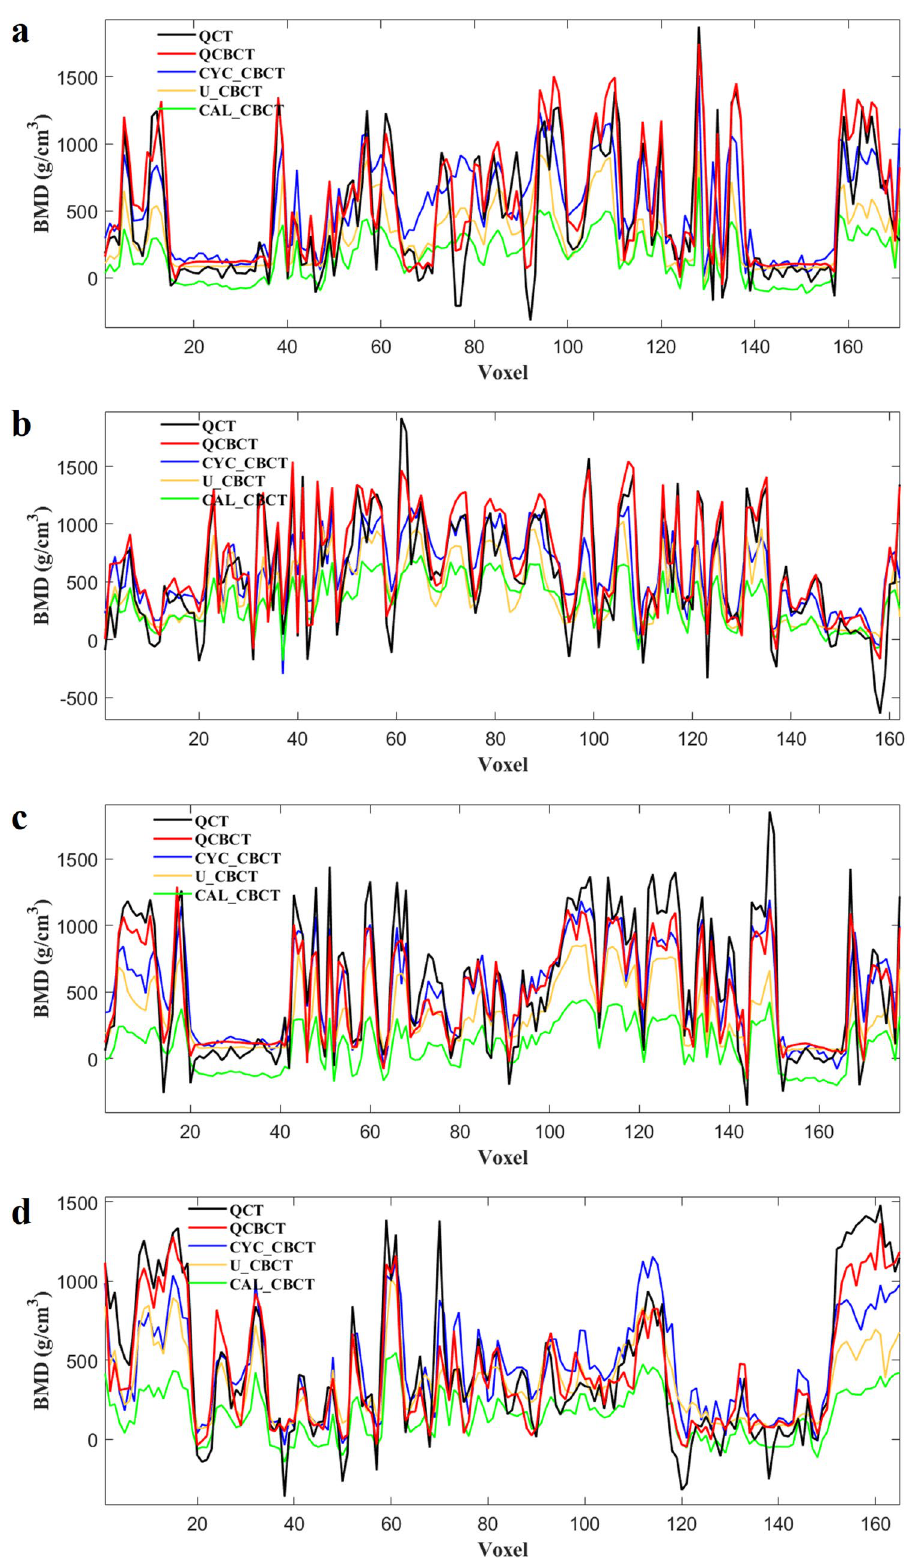
Figure 4. The BMD (voxel intensity) profiles along the dental arch at the maxilla and the mandible in the QCT, and QCBCT, CYC_CBCT, U_CBCT, and CAL_CBCT images shown in Fig. 2. Pearson correlation coefficients of QCBCT, CYC_CBCT, U_CBCT, and CAL_CBCT with the original QCT were ( a ) 0.92, 0.65, 0.60, and 0.65, respectively, for the profile at the maxilla and, ( b ) 0.93, 0.70, 0.65, and 0.69, respectively, for the profile at the mandible shown in Fig. 2b, and ( c ) 0.92, 0.89, 0.84, and 0.88, respectively, for the profile at the maxilla, and ( d ) 0.93, 0.81, 0.82, and 0.82, respectively, for the profile at the mandible shown in Fig.